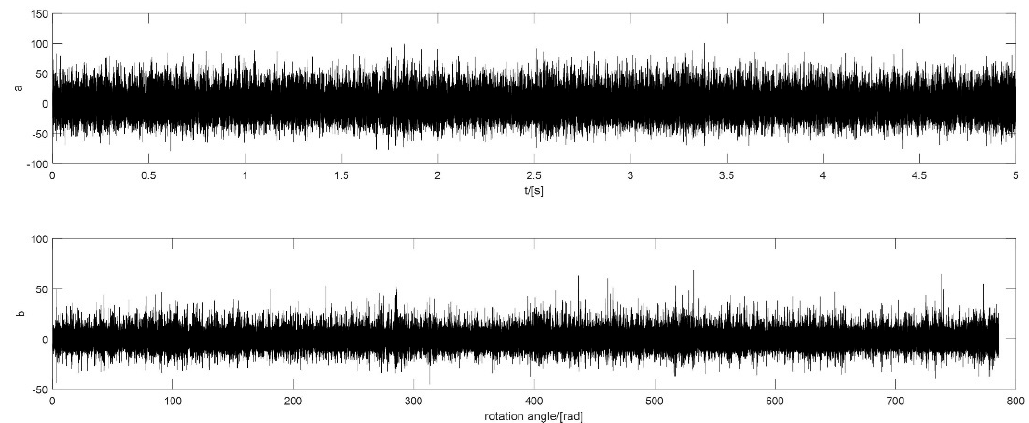
Figure 9. The vibration signal of outer ring defect with a constant speed: ( a ) the raw signal; ( b ) the signal after pre ‐ processing. signal after